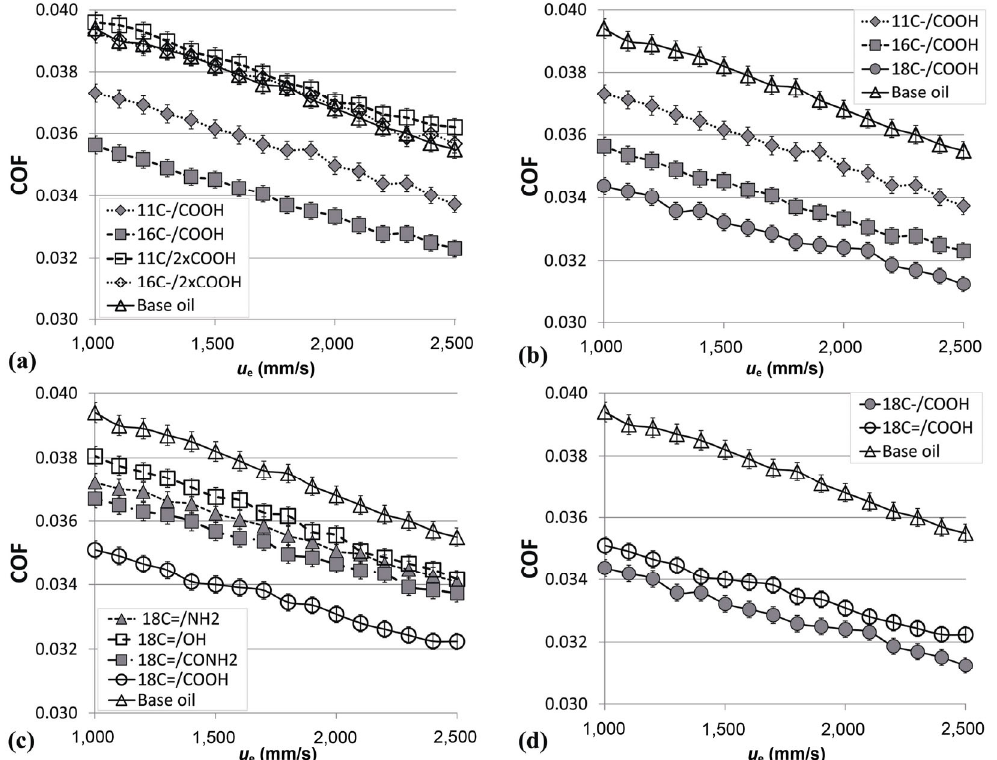
Fig. 2 EHD friction at 25 ℃ depending on additive variation of the (a) number of COOH groups; (b) alkyl chain length; (c) functional groups polarity; and (d)